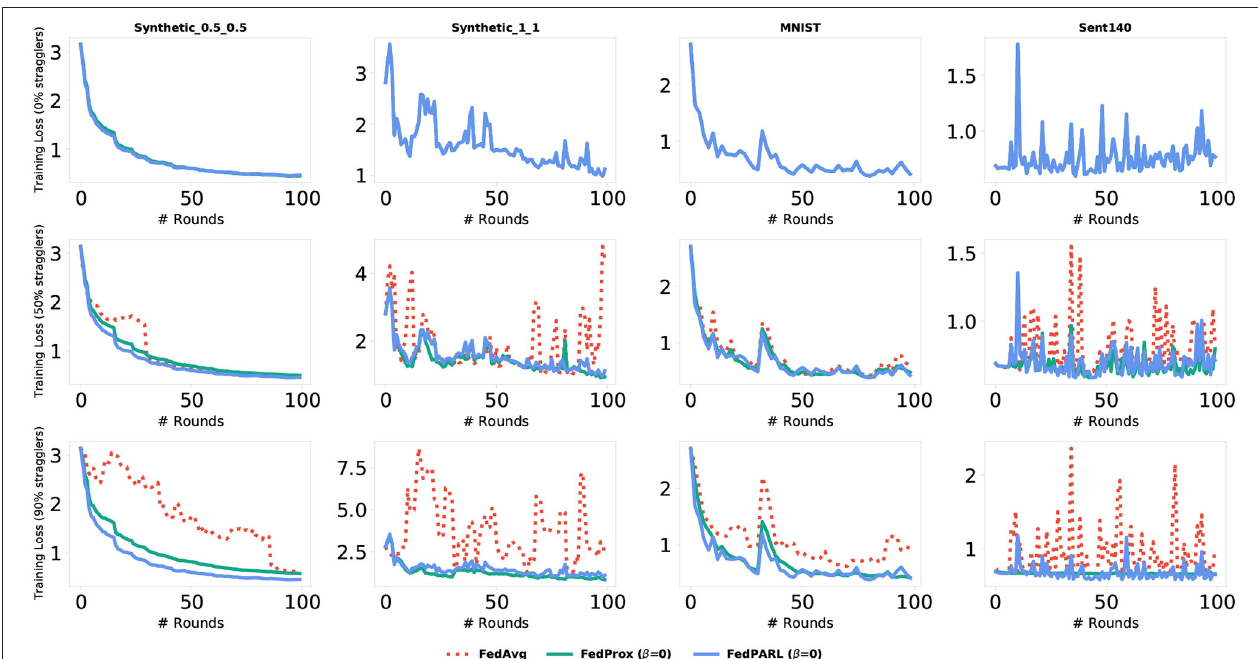
0) with FedAvg and FedProx in the presence =